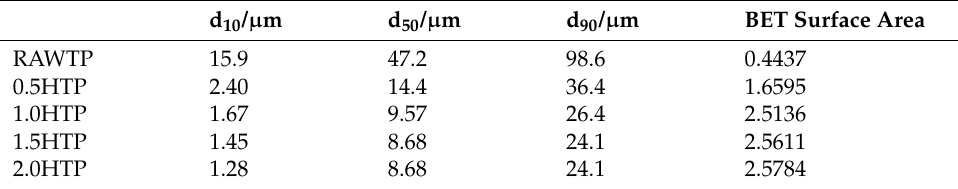
Figure 3. Particle size distribution variation of TP during mechanical activation. Table 2. The physical properties of TP after mechanical activation.